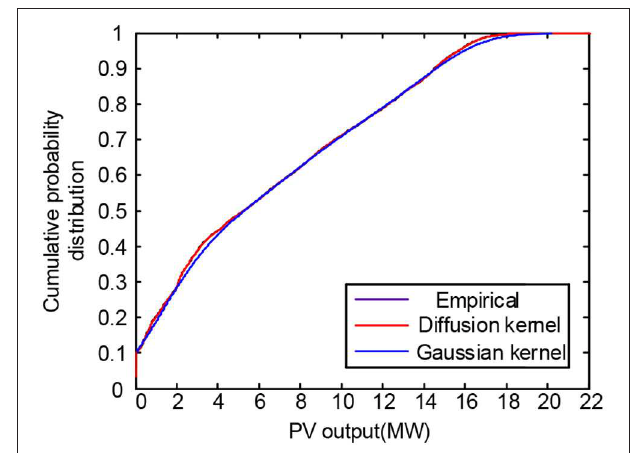
FIGURE 2 | Joint probability density of empirical Copula.